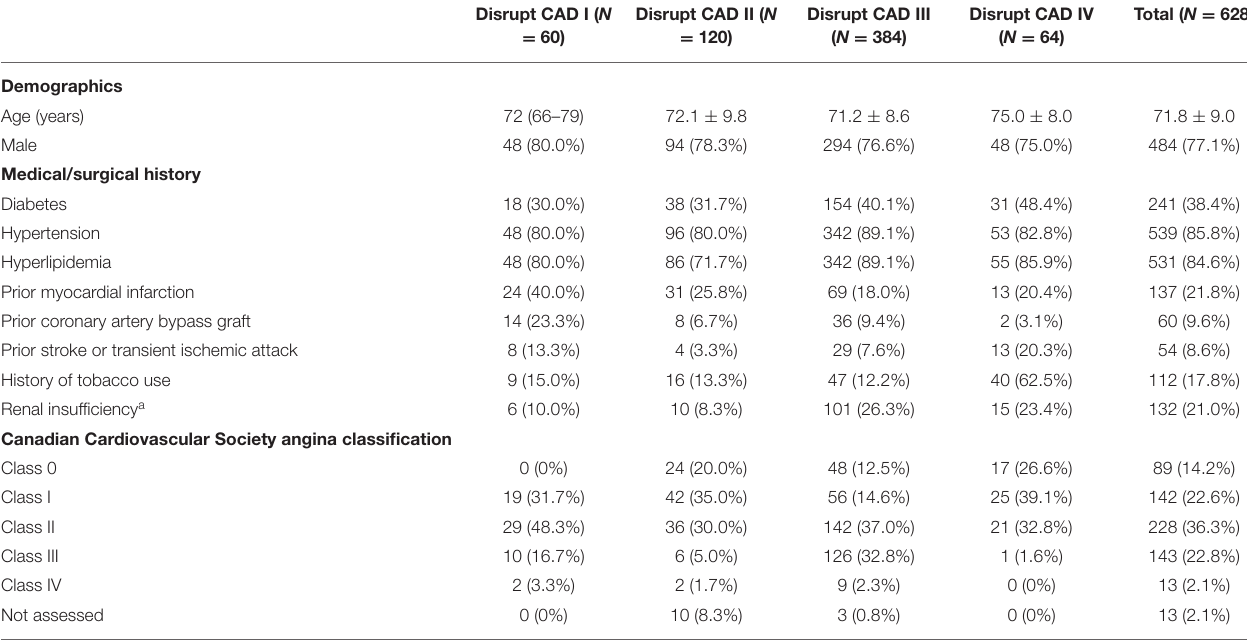
TABLE 2 | Baseline and clinical demographics.